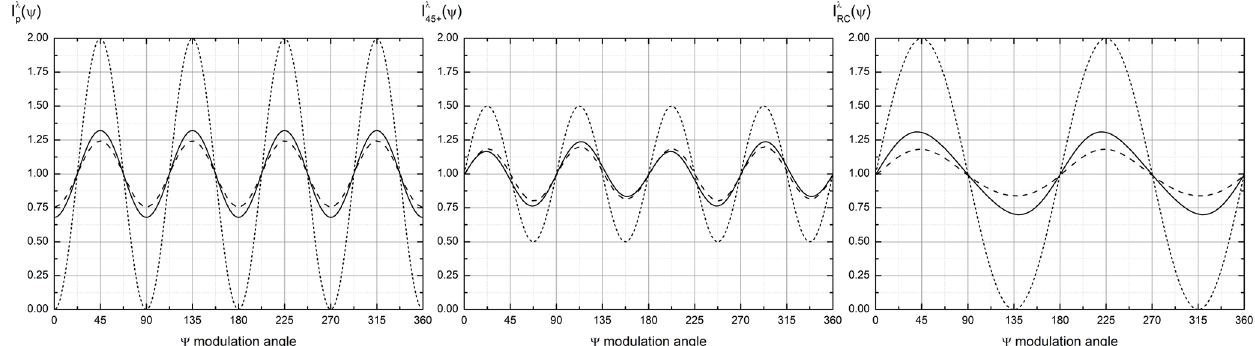
(ψ) as a function of the ψ angle of the analyser for the three i × a λ = 1) so that any i 0